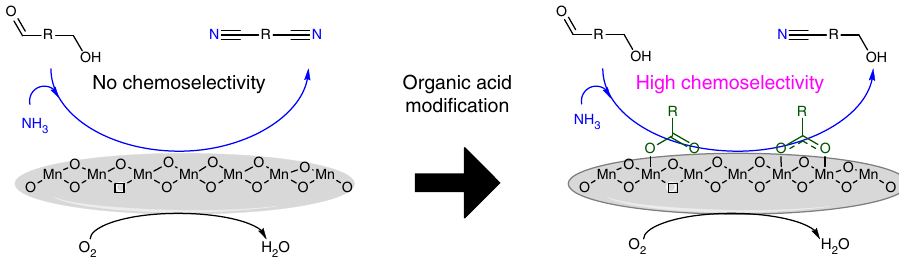
Fig. 1 Design strategy for controlling the reaction selectivity over MnO x catalysts. Schematic illustration of the strategy for achieving the selectivity-tunable aerobic ammoxidation of hydroxyaldehyde by an organic carboxylic acid-modi fi ed MnO x